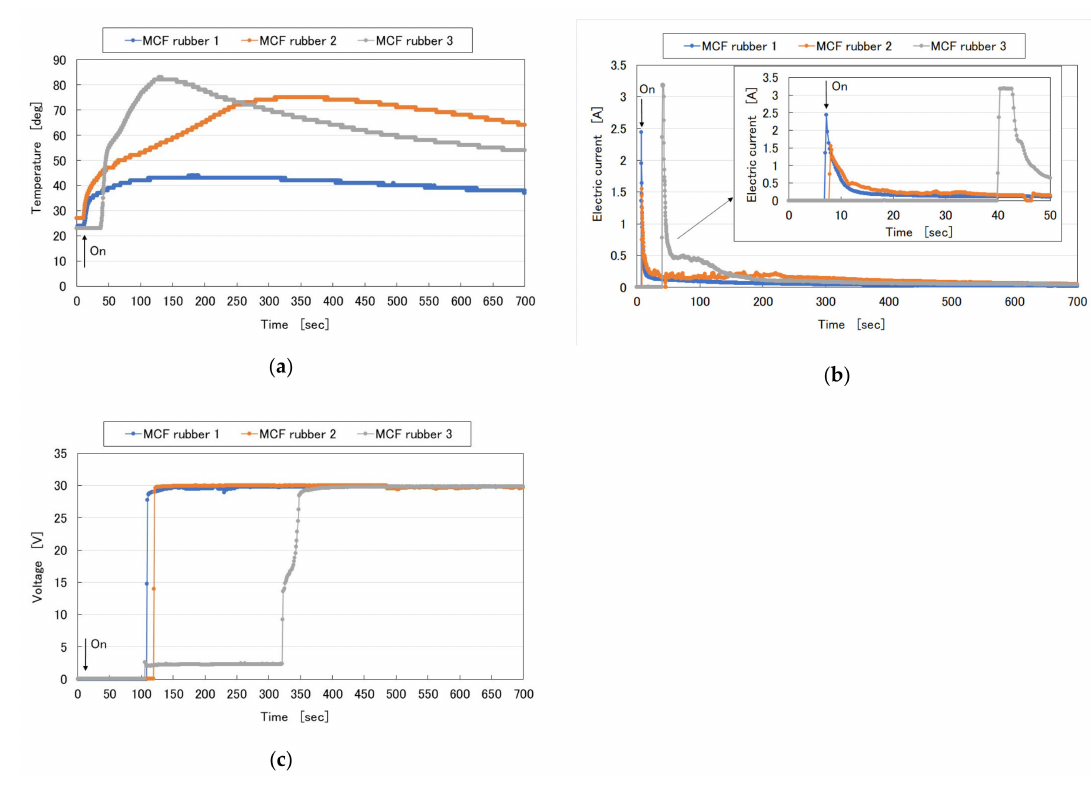
Figure 19. Change in temperature, electric current, and voltage of MCF rubber liquid during electrolytic polymerization: ( a ) temperature; ( b ) current; ( c )